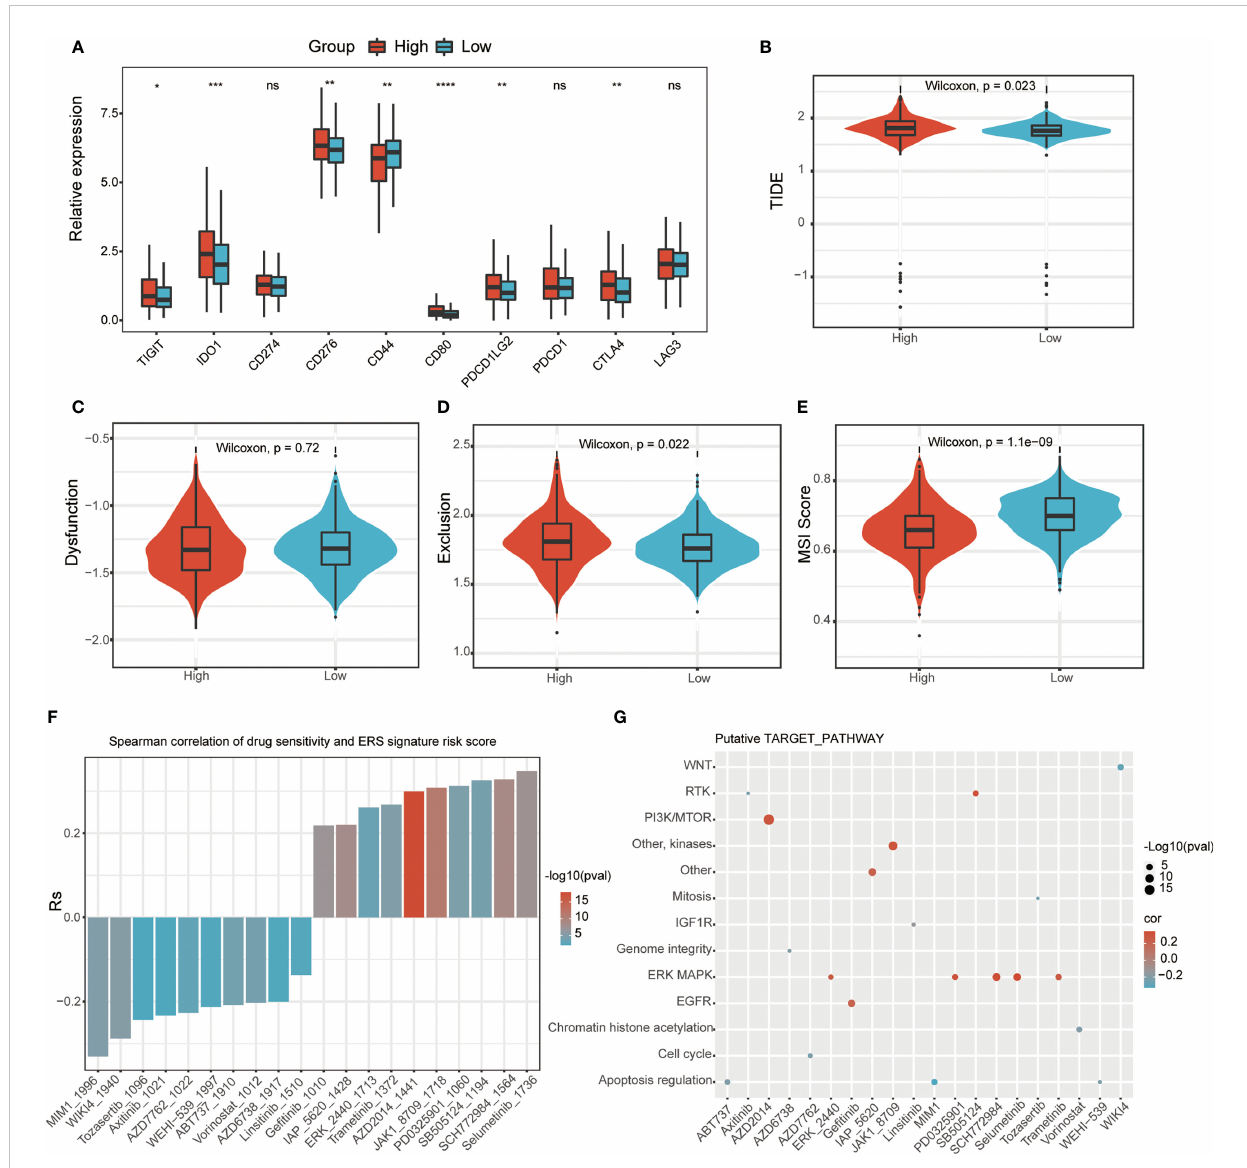
FIGURE 7 Relationship between ERS-related signature scores and immune response and drug sensitivity. (A) Immune checkpoint analysis between two ERS risk groups (ns, not signi fi cant; * p < 0.05; ** p < 0.01; *** p < 0.001; **** p < 0.001). TIDE (B) , dysfunction score (C) , and T-cell exclusion (D) and MSI (E) in different ERS risk groups in the PRAD dataset. (F) The correlation between ERS risk scores and drug sensitivity (AUC values of GDSC) examined by the Spearman analysis. (G) Putative targets or functional pathways of the drugs that are sensitive to the ERG risk scores (ns, not signi fi cant; * p <